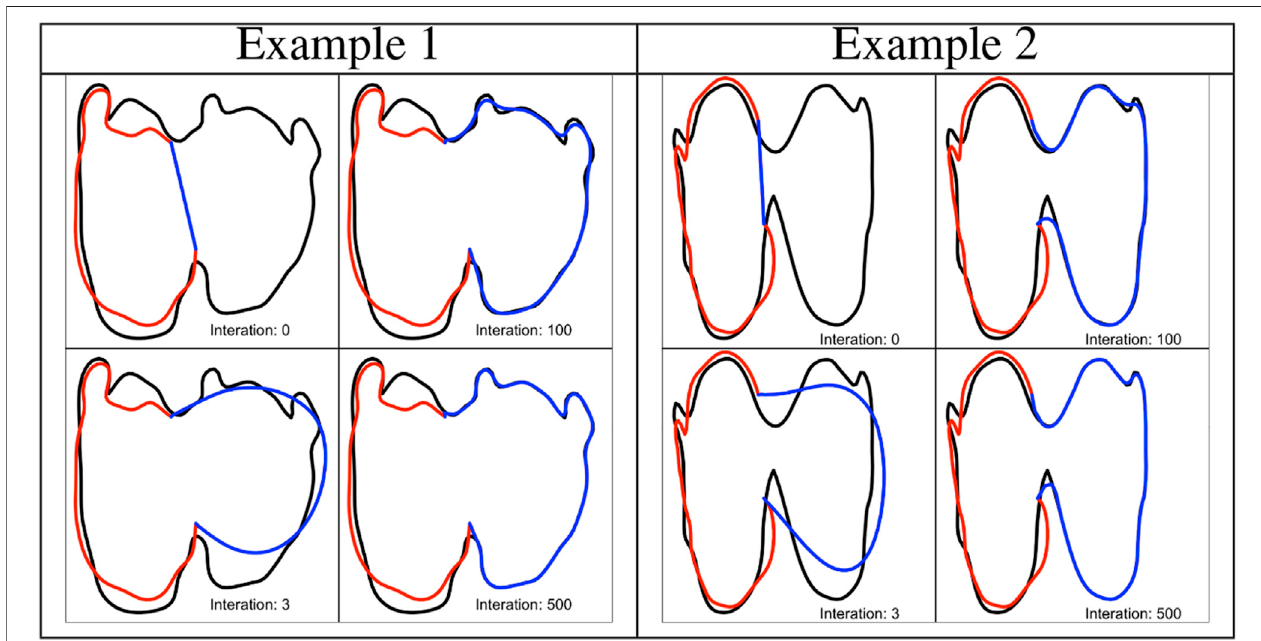
FIGURE 2 | Two examples of shape imputation via Algorithm 1 . The panels show the evolution of the completion (blue) at a few iterations of step 3, the observed partial curve (red) and the donor (black).